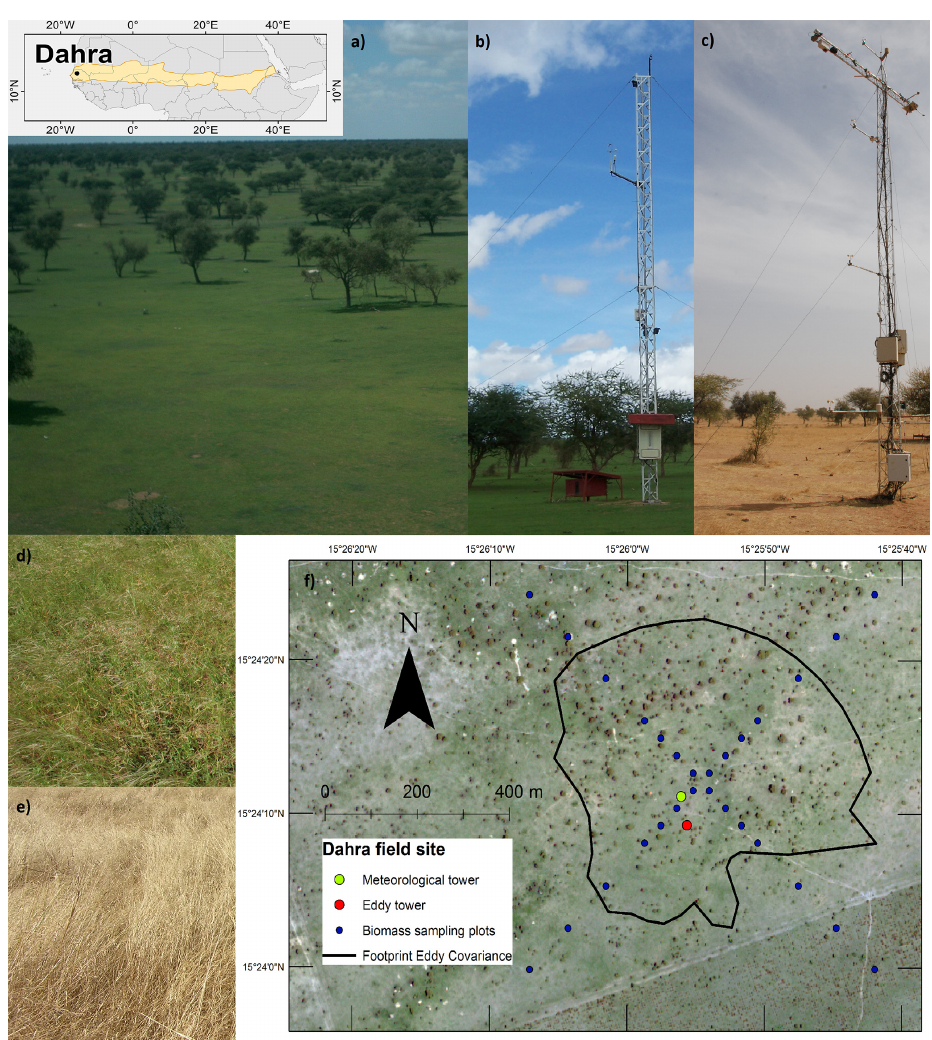
Figure 1. Map and photos of the Dahra field site and measured areas. The map shows the location of Dahra within the Sahel (orange area). (a) Photo of the footprint of the eddy covariance (EC) tower; (b) photo of the EC tower; (c) photo of the meteorological tower with the spectroradiometers; (d) photo of the instantaneous field of view (IFOV) of the spectroradiometers during the rainy season; (e) photo of the IFOV of the spectroradiometer during the beginning of the dry season; and (f) Quickbird image from the Dahra field site from 11 September 2011 showing the location of the meteorological tower, the EC tower, the biomass sampling plots, and the footprint of the EC measurements. The EC footprint area is the median 70% cumulative flux distance from the eddy covariance tower. The photos of the EC tower and its footprint are taken during the rainy season, whereas the photo of the meteorological tower shows the late dry